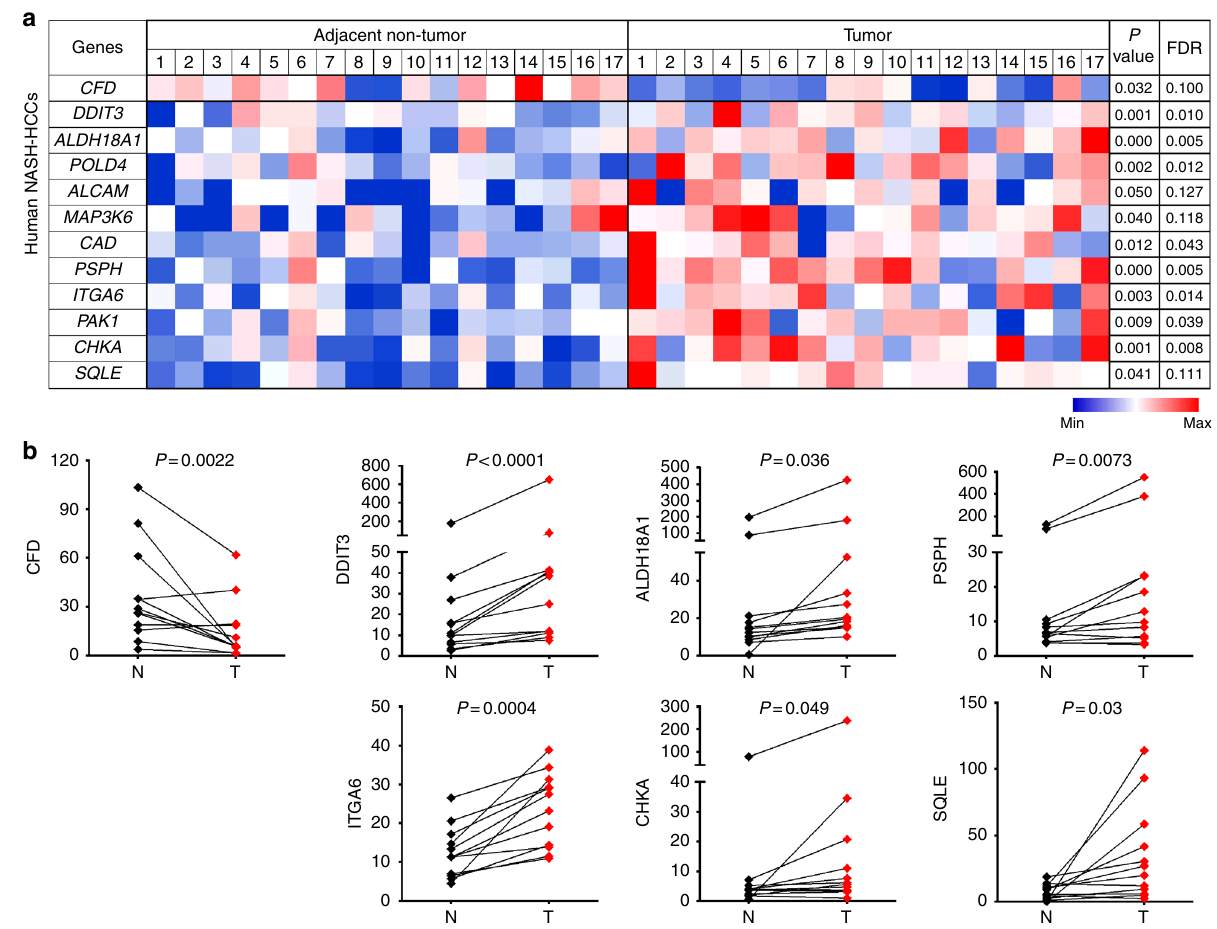
Fig. 4 Aberrant gene expression veri fi ed in human NASH-HCC samples as compared to adjacent non-tumor livers. a Shown are RNA levels in FPKM in 17 pairs of tumors compared to adjacent non-tumor livers from patients with NASH-HCC. P values by paired t tests and FDR adjusted by Benjamini – Hochberg method are shown. Expression levels were normalized to the mean level of each gene among all samples shown. b Expression of seven genes was further validated to be signi fi cantly altered in 12 pairs of NASH-HCCs (T) compared to adjacent non-tumor livers (N) by RT-qPCR. Comparison by paired t